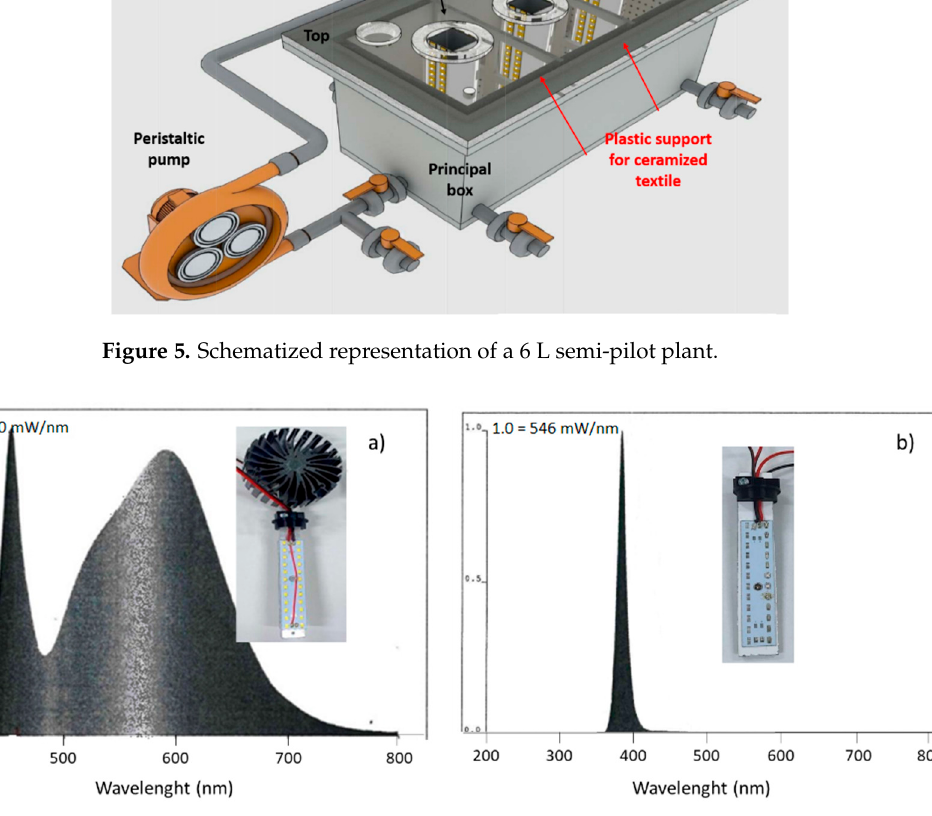
Figure 6. Emission spectrum of ( a ) visible LED light and ( b ) UV LED light, including photographs of the corresponding LED strips, mounting an air-cooling fan.